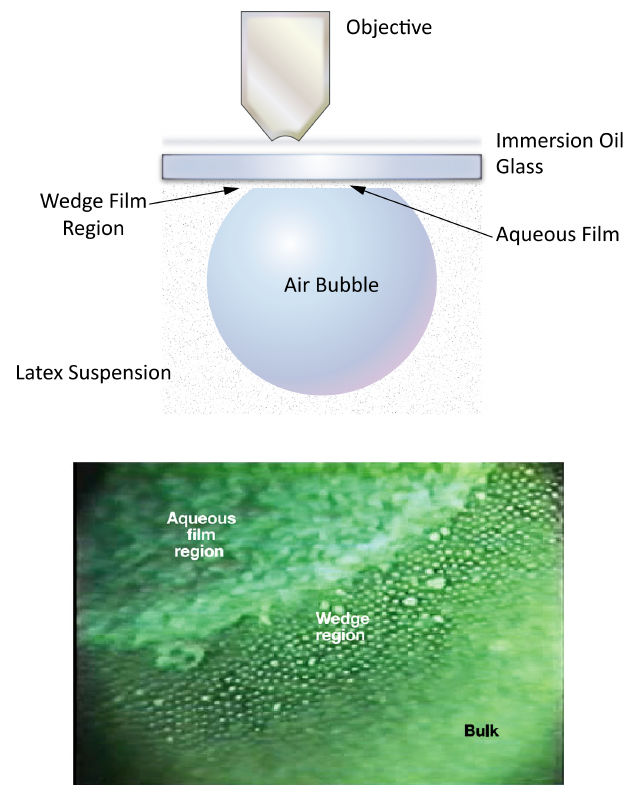
Figure 9. Nanoparticles in a wedge film. Scheme of the experimental set-up ( top ) and the nanoparticle distribution in a wedge film ( bottom ). Latex particles had diameter 1 µ m. Figure adapted (top) and reproduced (bottom) from Ref.